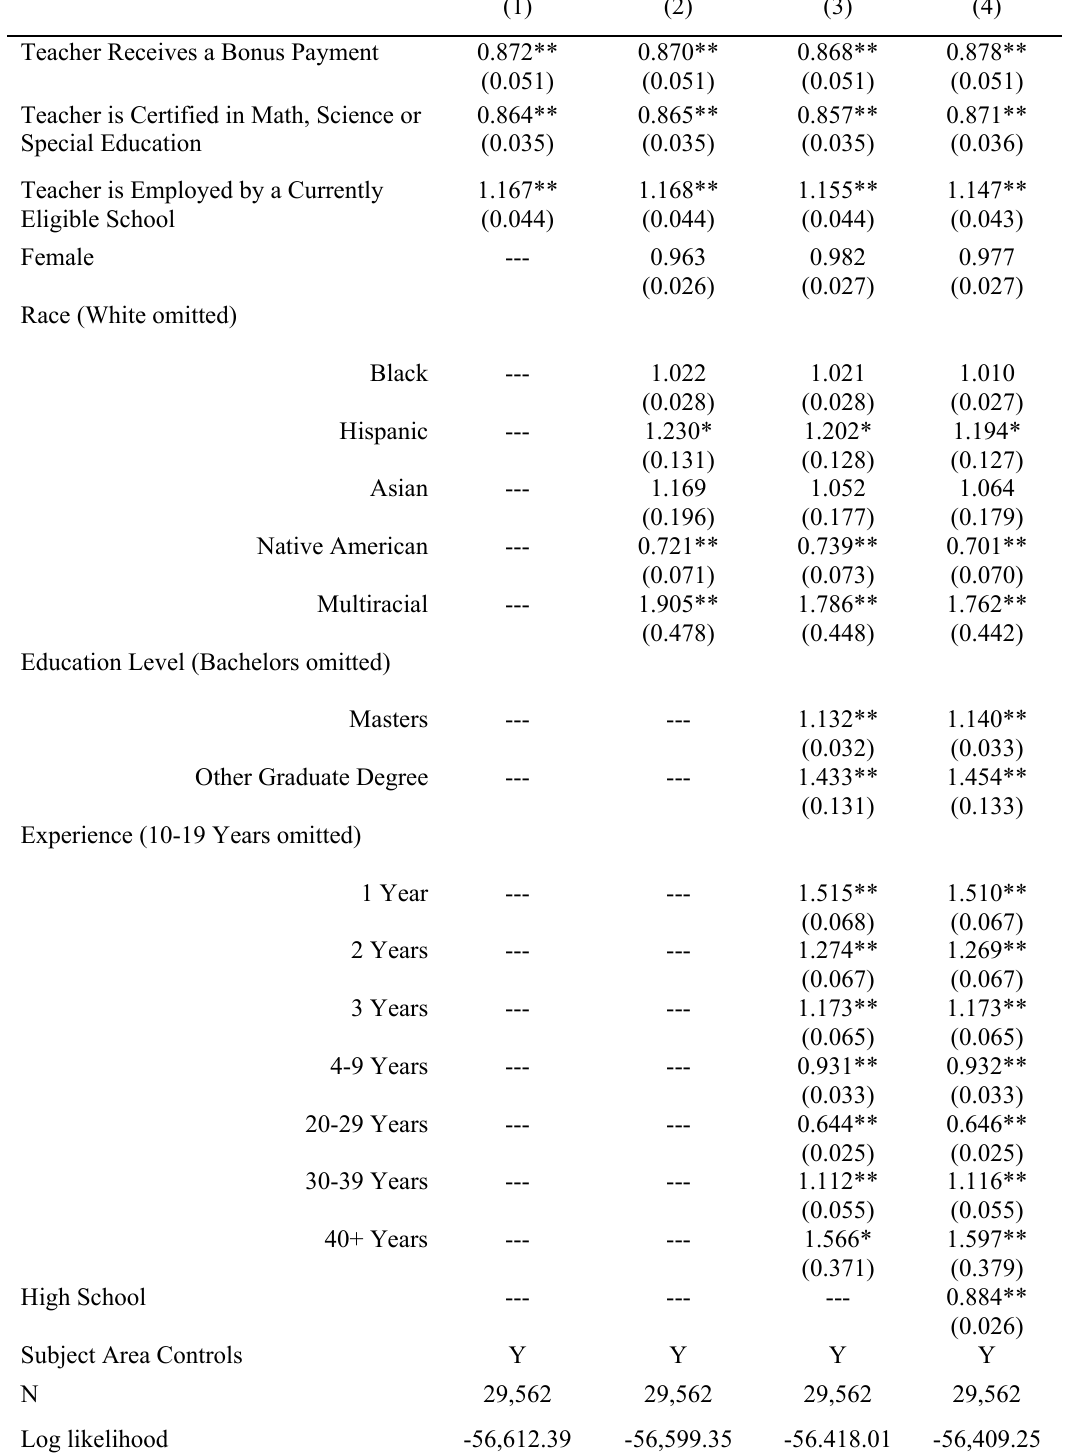
Table 4 : Refined Estimates of the Program’s